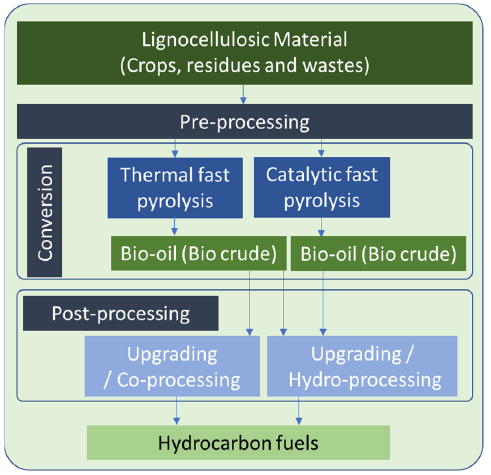
Figure 12. PVC2–BtL via pyrolysis. Adapted from [26].